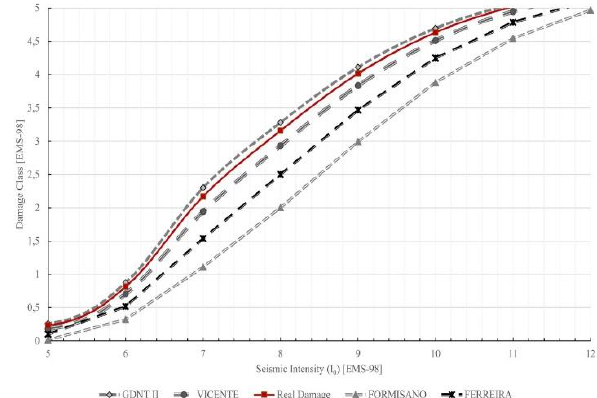
Figure 14. Vulnerability curves for different seismic intensities using the IV methods